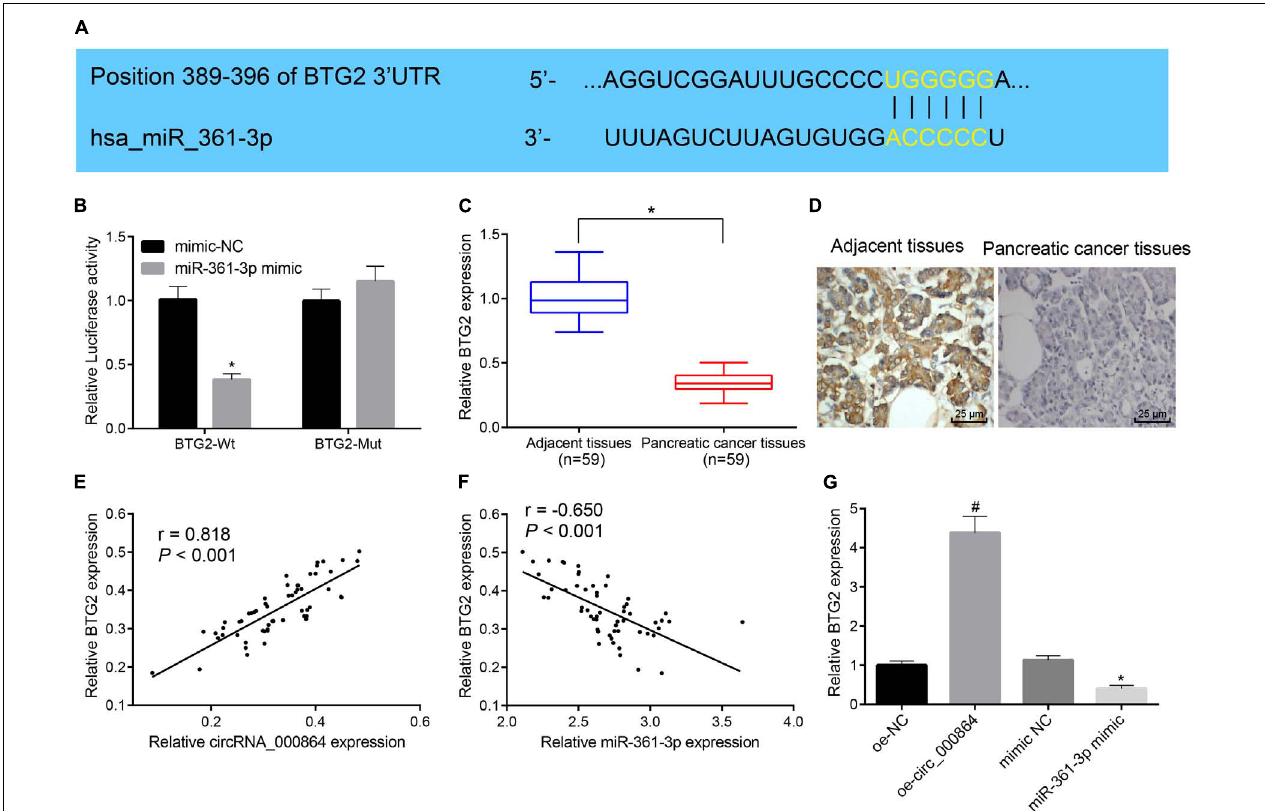
FIGURE 6 | CircRNA_000864 binds to miR-361-3p to upregulate BTG2. (A) The predicted binding site of miR-361-3p and BTG2 through the biological website. (B) The targeting relationship between miR-361-3p and BTG2 assessed by dual-luciferase reporter gene assay. (C) BTG2 expression in pancreatic cancer tissues and adjacent normal tissues detected by RT-qPCR normalized to GAPDH ( n = 59). (D) BTG2 expression in pancreatic cancer tissues and adjacent normal tissues detected by immunohistochemistry ( × 400) ( n = 59). (E) The correlation analysis of circRNA_000864 and BTG2. (F) The correlation analysis of miR-361-3p and BTG2. (G) BTG2 expression in AsPC-1 cells after overexpression of circRNA_000864 and miR-361-3p detected by RT-qPCR normalized to GAPDH. * p < 0.05 vs. adjacent normal tissues or AsPC-1 cells transfected with mimic-NC. # p < 0.05 vs . AsPC-1 cells transfected with oe-NC. The above data were all measurement data. The statistical results of (B–G) were expressed as sample mean ± standard deviation and analyzed by the unpaired t -test. The remaining results were expressed as mean ± standard deviation. Data of (C) were compared by the paired t -test. The cell experiment was conducted three times